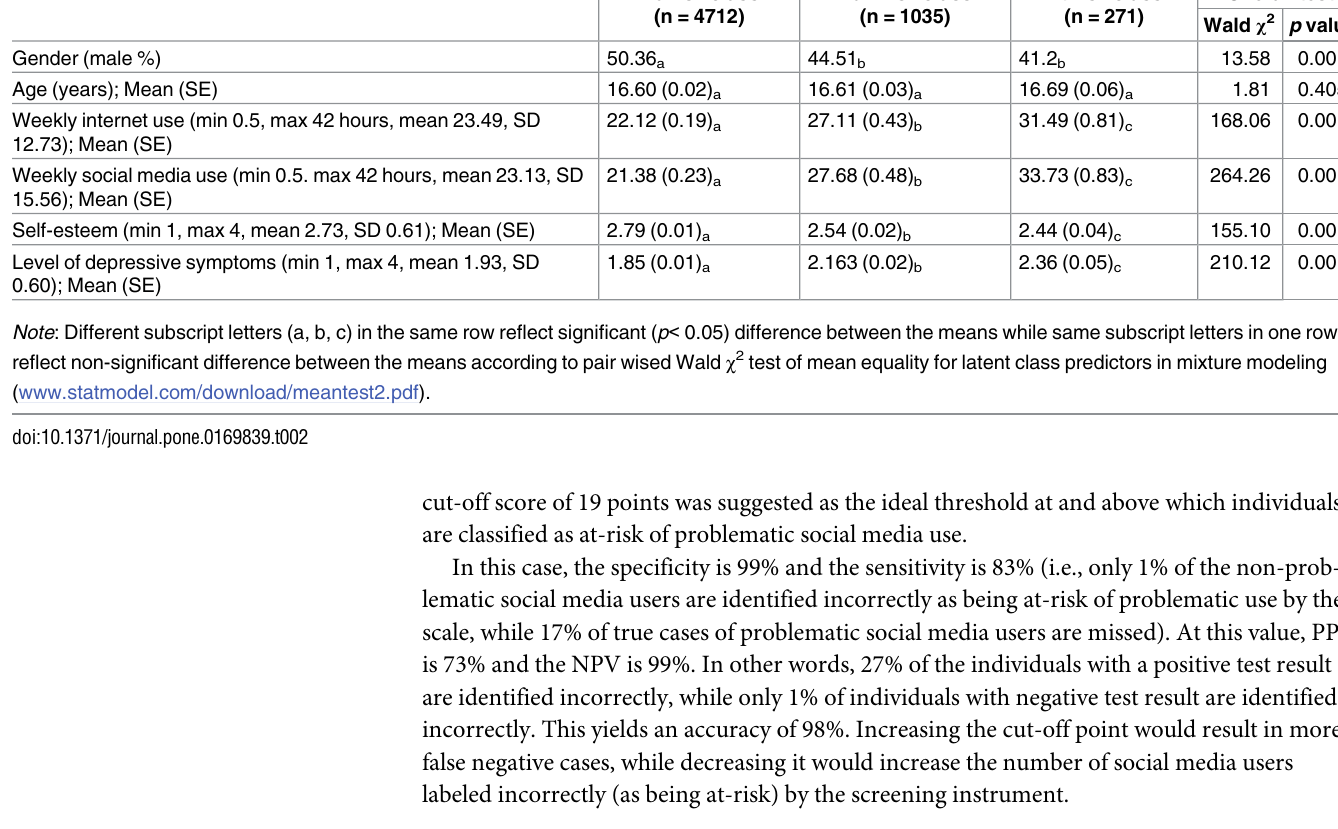
Table 2. Comparison of the Three Latent Classes: Testing Equality for Latent Class Predictors.